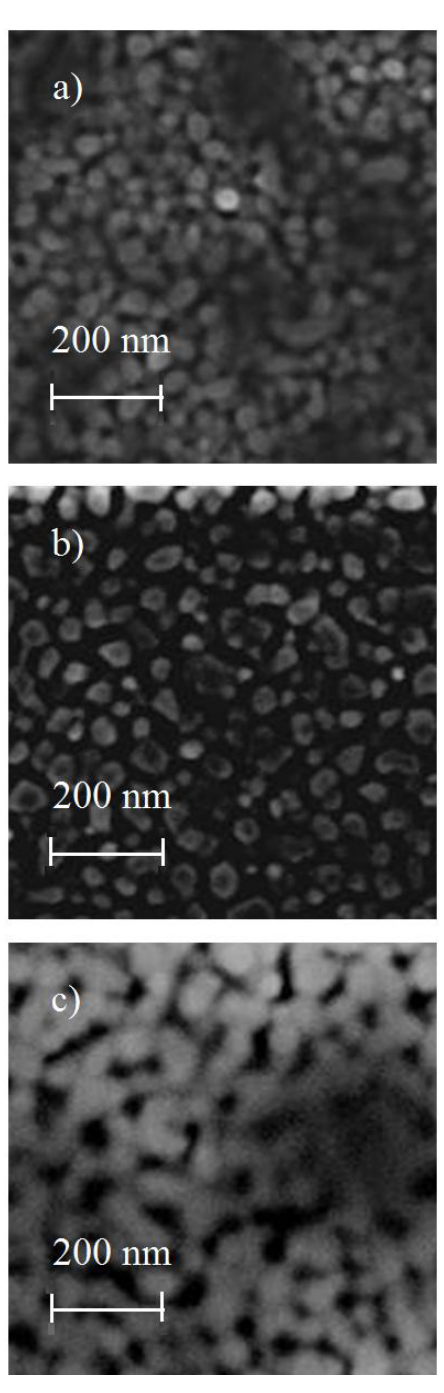
Figure 3. SEM images of ZnO:Cr thin films with different immersions number: ( a ) one, ( b ) three, and ( c ) five